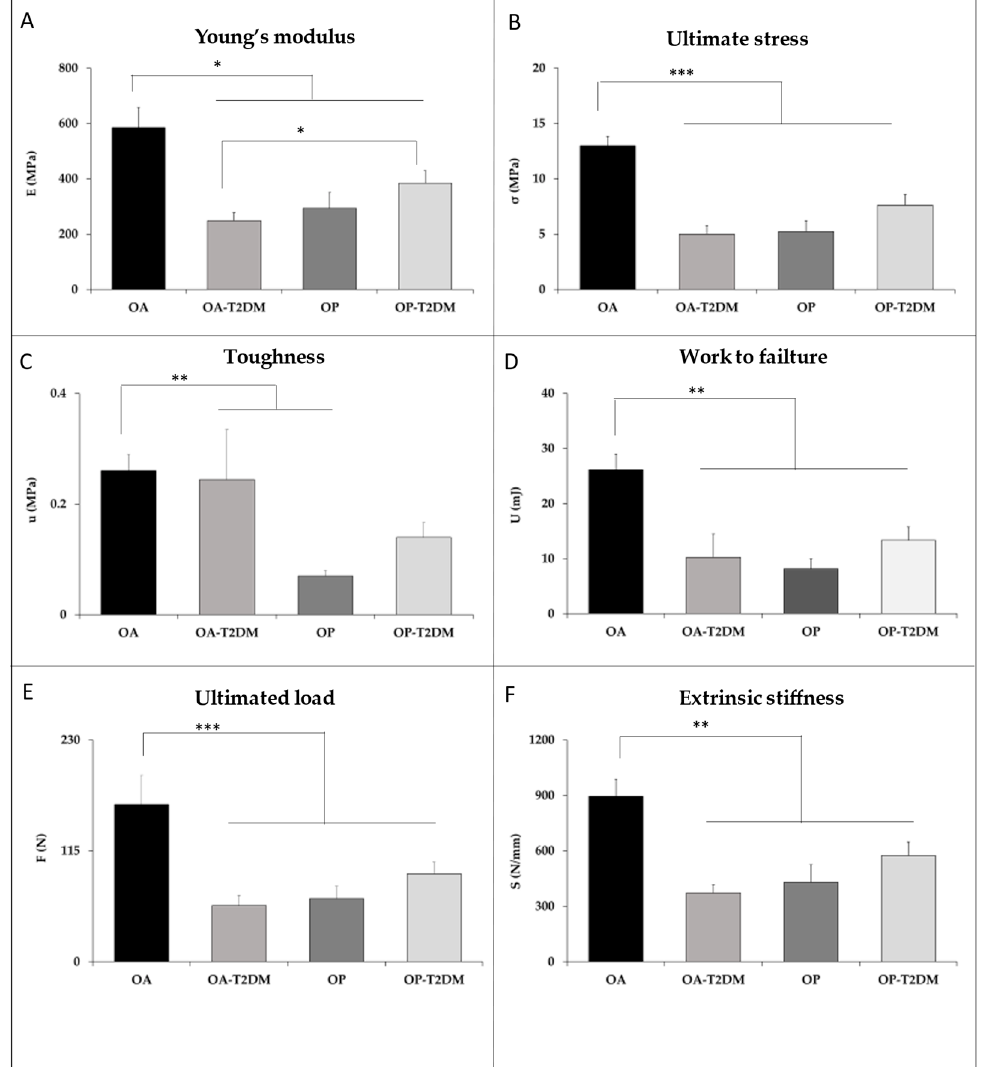
Figure 4. Comparisons of biomechanical parameters between patients with OA and OP.( A ) E, Young’s modulus or elastic modulus; ( B ) σ ult , ultimate stress; ( C ) u, toughness; ( D ) U, work to failure; ( E ) F ult , ultimate load; ( F ) S, extrinsic stiffness. Values are expressed as the means ± SEM. * p < 0.05, ** p < 0.01, and *** p < 0.001 statistically significant.